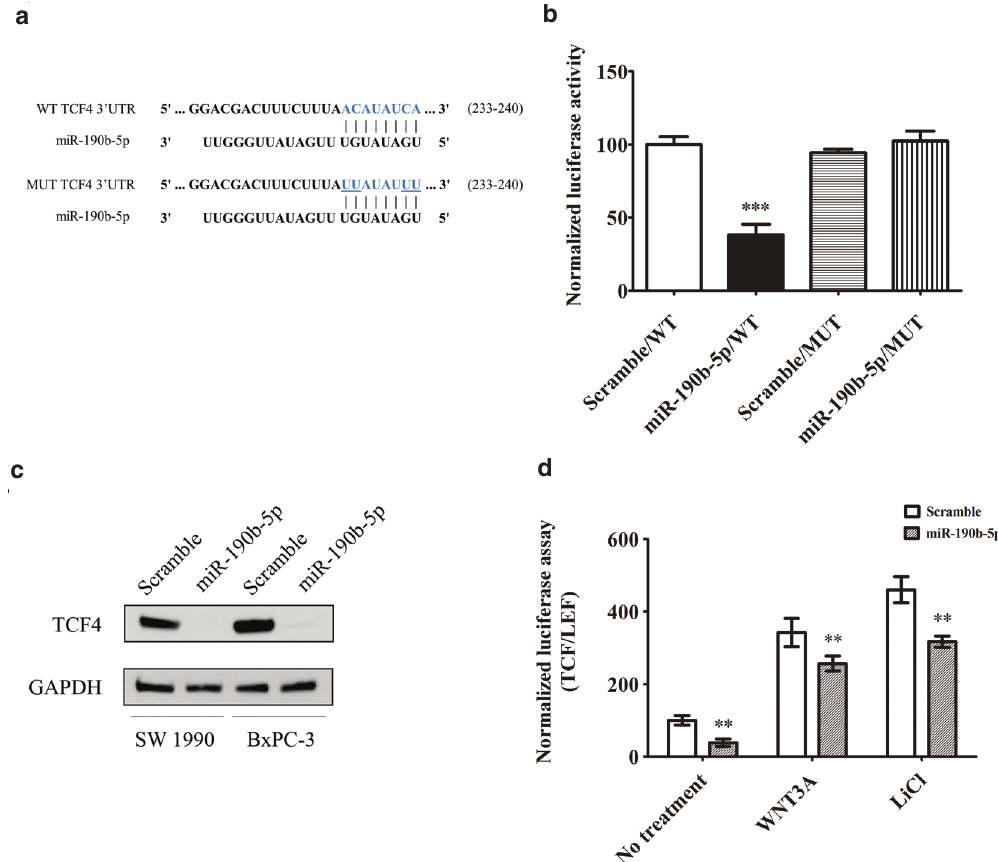
Fig. 5. TCF4 is a direct target of miR-190b-5p. (a) Schematic diagram of a conserved putative miR-190b-5p targeting site in 3’UTR of TCF4 (WT). The site mutations were introduced to miR-190b-5p targeting site of 3’UTR (MUT). (b) Luciferase reporter assay study of the interaction between miR-190b-5p and 3’UTR of TCF4. Pancreatic cancer cells were first transfected with luciferase reporter genes conjugated with either wildtype (WT) or mutant (MUT) 3’UTR of TCF4. Twenty-four hours later, cells were transfected with either miR-190b-5p mimic or scramble control. Transfected cells were cultured for 48 h and then harvested for the measurement of luciferase activities in a plate reader. (c) Western blotting analysis of TCF4 protein ex- pression in cells transfected with miR-190b-5p or scramble control. The cells were transfected with either miR-190b-5p mimic or scramble control for 48 h before harvesting. GAPDH was used as loading control. (d) Luciferase reporter assay study of the regulatory effect of miR-190b-5p in Wnt pathway. Cells were cotransfected with TCF/LEF luciferase reporter genes with either miR-190b-5p mimic or scramble control. Forty-eight hours later, the transfected cells were treated with either WNT3A or LiCl. The activation of Wnt pathway was assessed in a plate reader. The data were presented as means ± SD of three independent experiments (* P < 0.05, ** P < 0.01, and *** P < 0.001 as compared with control, in one-way